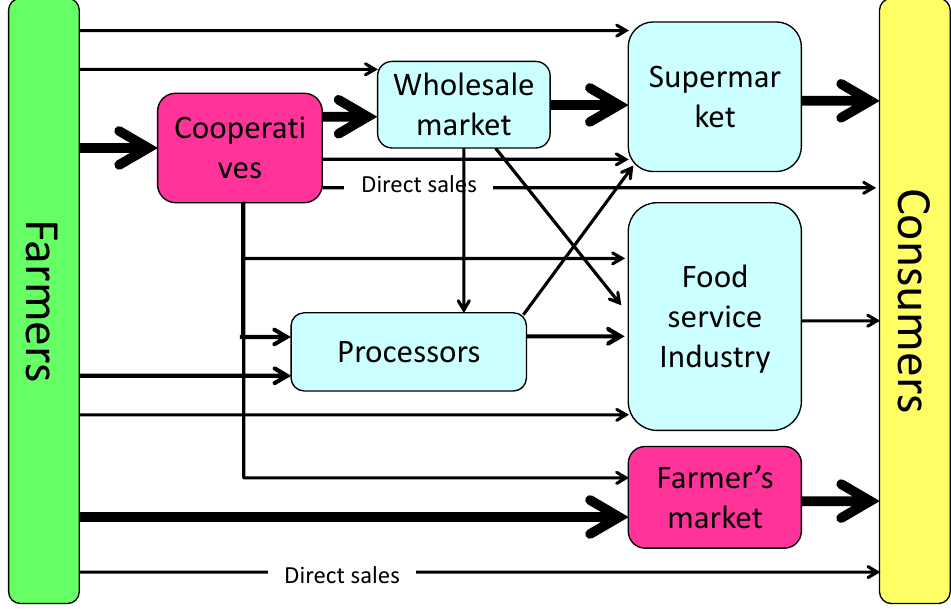
Figure 3. Main vegetable distribution routes in Japan. Source: JALIC Statistics.